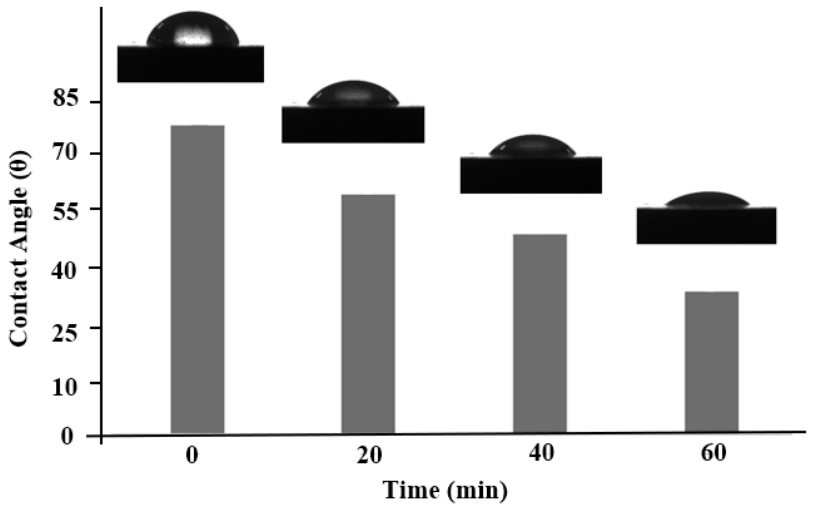
Figure 12. Wettability of the P(VDF-TrFE)/BaTiO 3 film through the contact angle.